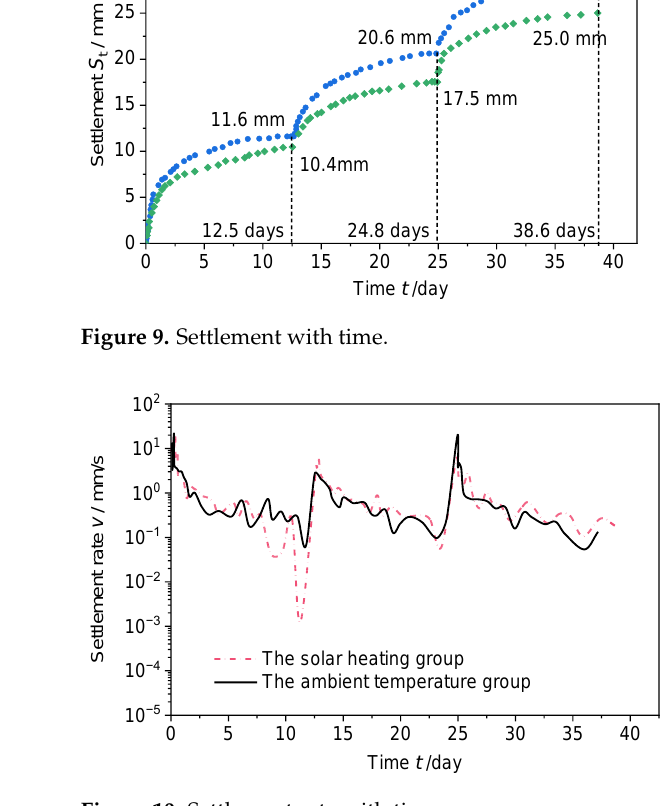
Figure 10. Settlement rate with time.